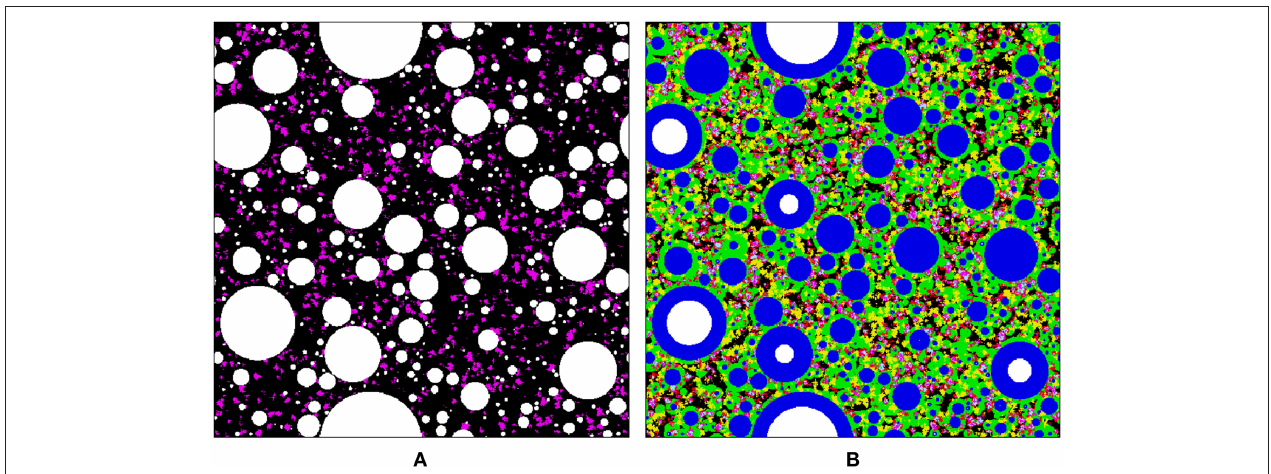
FIGURE 11 | Sketch of the microstructure of SF incorporated cement paste: (A) initial status; (B) mature paste. In the images, colors represent specific phases: white, anhydrous cement; blue, inner hydration products; green, outer C-S-H layer; yellow, crystalline hydrate (including CH); magenta, agglomerated SF particles; cyan/red, secondary C-S-H formed in pozzolanic reaction of